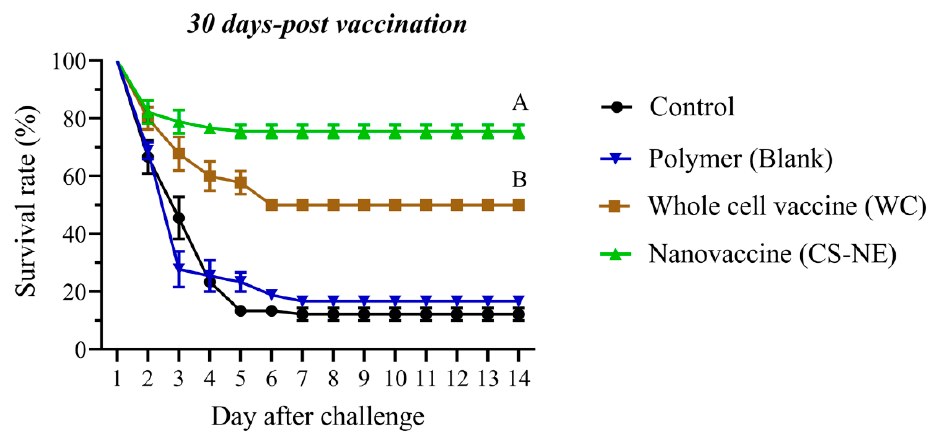
Figure 4. The percentage survival in vaccinated fish after immersion challenge with 1 × 10 7 CFU/mL F. columnare (strain F-K17/1), i.e., non-vaccinated, polymer, WC and CS-NE groups (30 from each group, 3 replicate tanks). The CS-NE vaccinated fish showed significantly higher levels of survival. Different capital letters indicate significant differences ( p < 0.05) among groups at 14 days post- challenge. One-way analysis of variance, and repeated measures analysis of variance followed by Bonferroni’s multiple comparison test were used for statistical analysis .